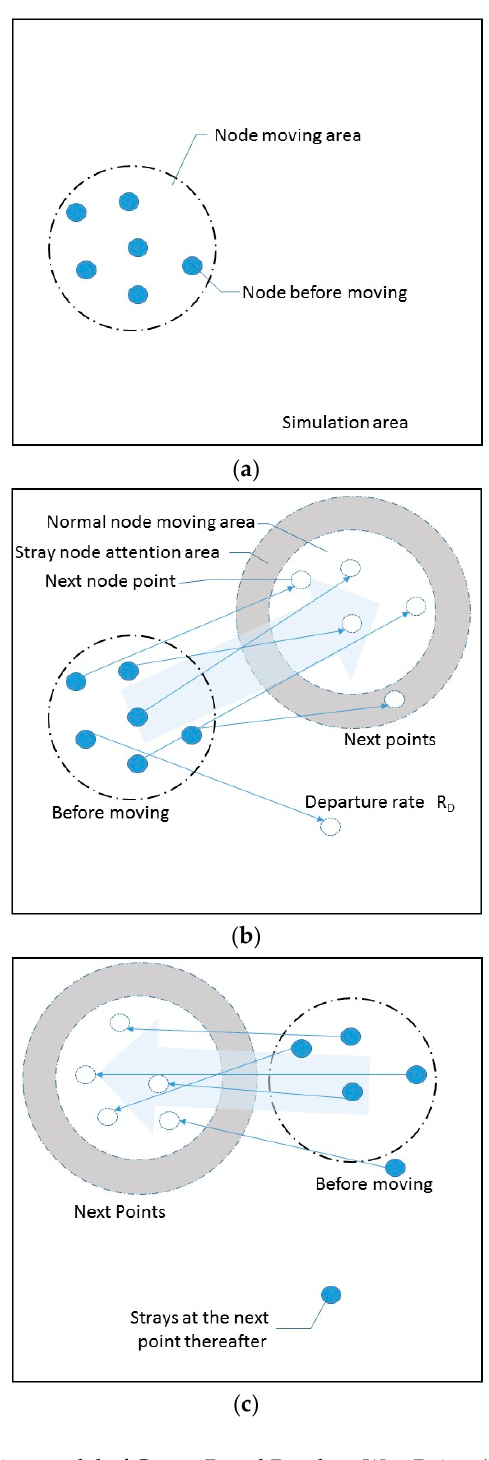
Figure 9. Example transition model of Group Based Random Way Point: ( a ) At the beginning of the simulation; ( b ) determination of the next points; ( c ) movement after the previous movement.